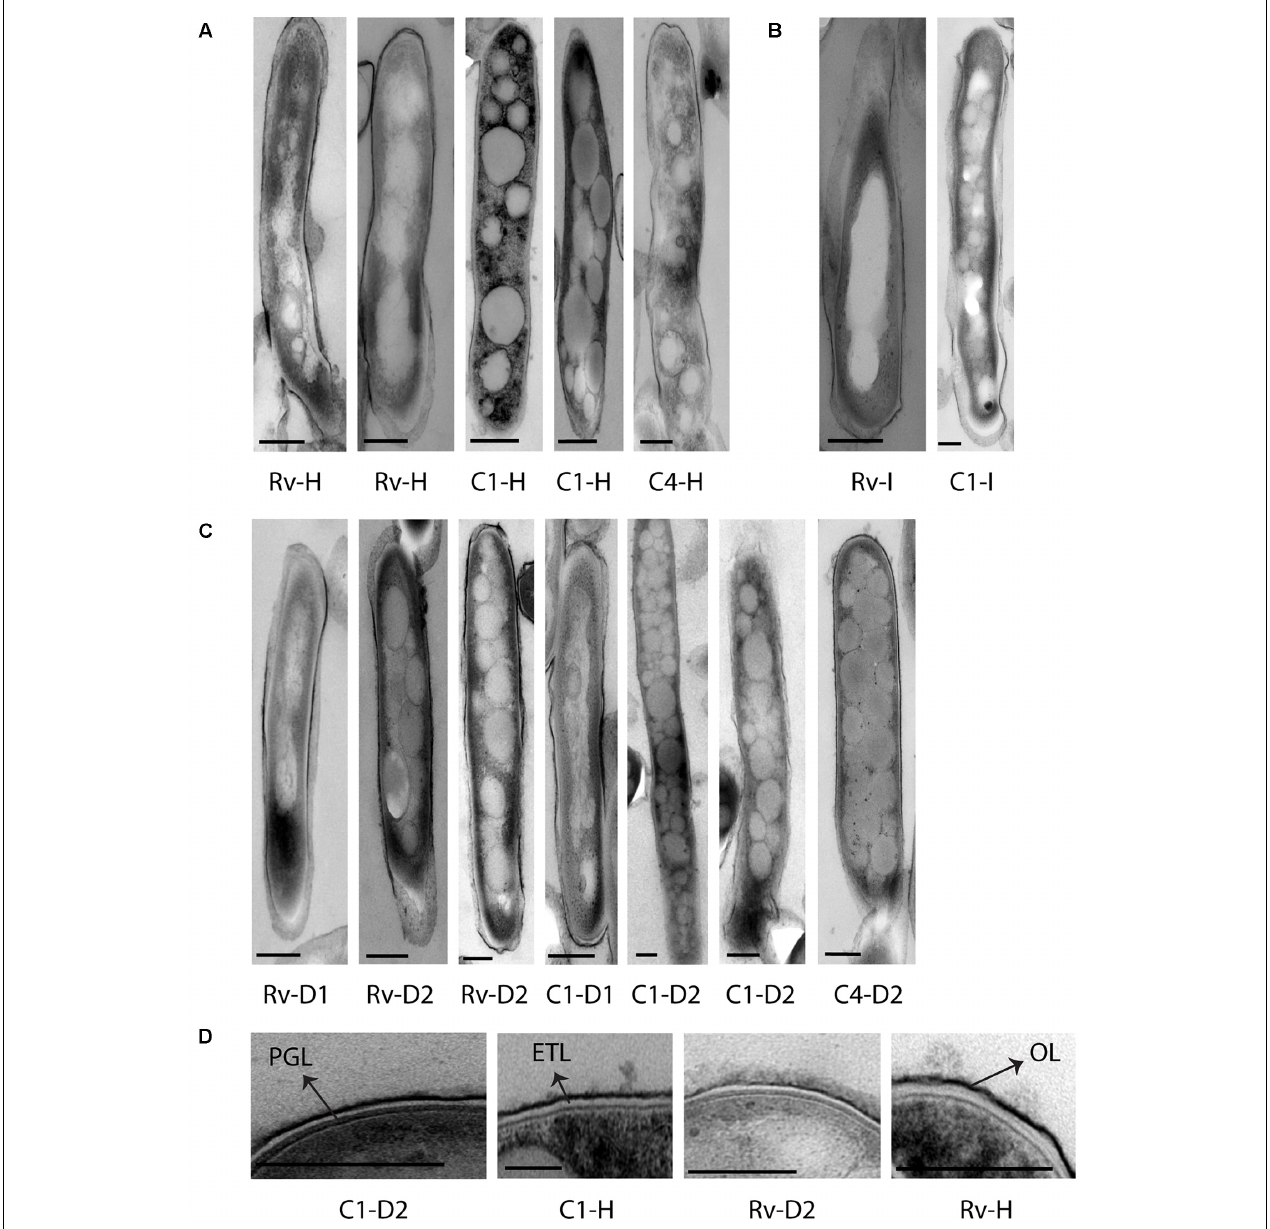
FIGURE 4 | Cellular ultrastructure of M. tuberculosis strains under H 2 O 2 , isoniazid treatment, and iron deficiency displaying accumulation of lipid inclusions and thin cell envelope ETL. (A) TEM images of H37Rv [Rv-H (two images)] and clinical M. tuberculosis strains [C1-H (two images) and C4-H] under H 2 O 2 treatment. (B) TEM image of H37Rv and clinical M. tuberculosis strain grown under isoniazid treatment (Rv-I and C1-I). (C,D) TEM images of H37Rv and clinical M. tuberculosis strains grown under iron deficiency DFO-100 (Rv-D1, C1-D1) and 500 µ M [Rv-D2 (two images), C1-D2 (two images) and C4-D2]. DFO, deferoxamine mesylate salt; OL, outer layer; ETL, electron transparent layer; PGL, peptidoglycan layer; scale bar = 200